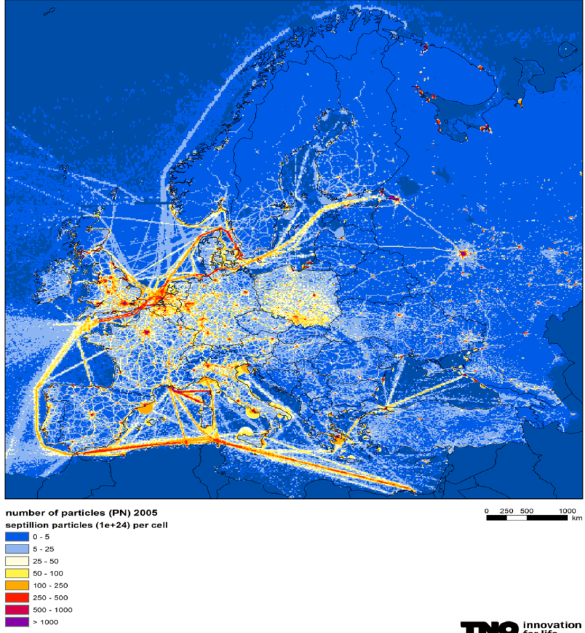
Figure 4. Spatial distribution of anthropogenic PN emissions in Europe in 2005, on a longitude–latitude grid, on a resolution of 1/8 ◦ × 1/16 ◦ . The unit of the legend is 10 24 particles per compu- tational cell per